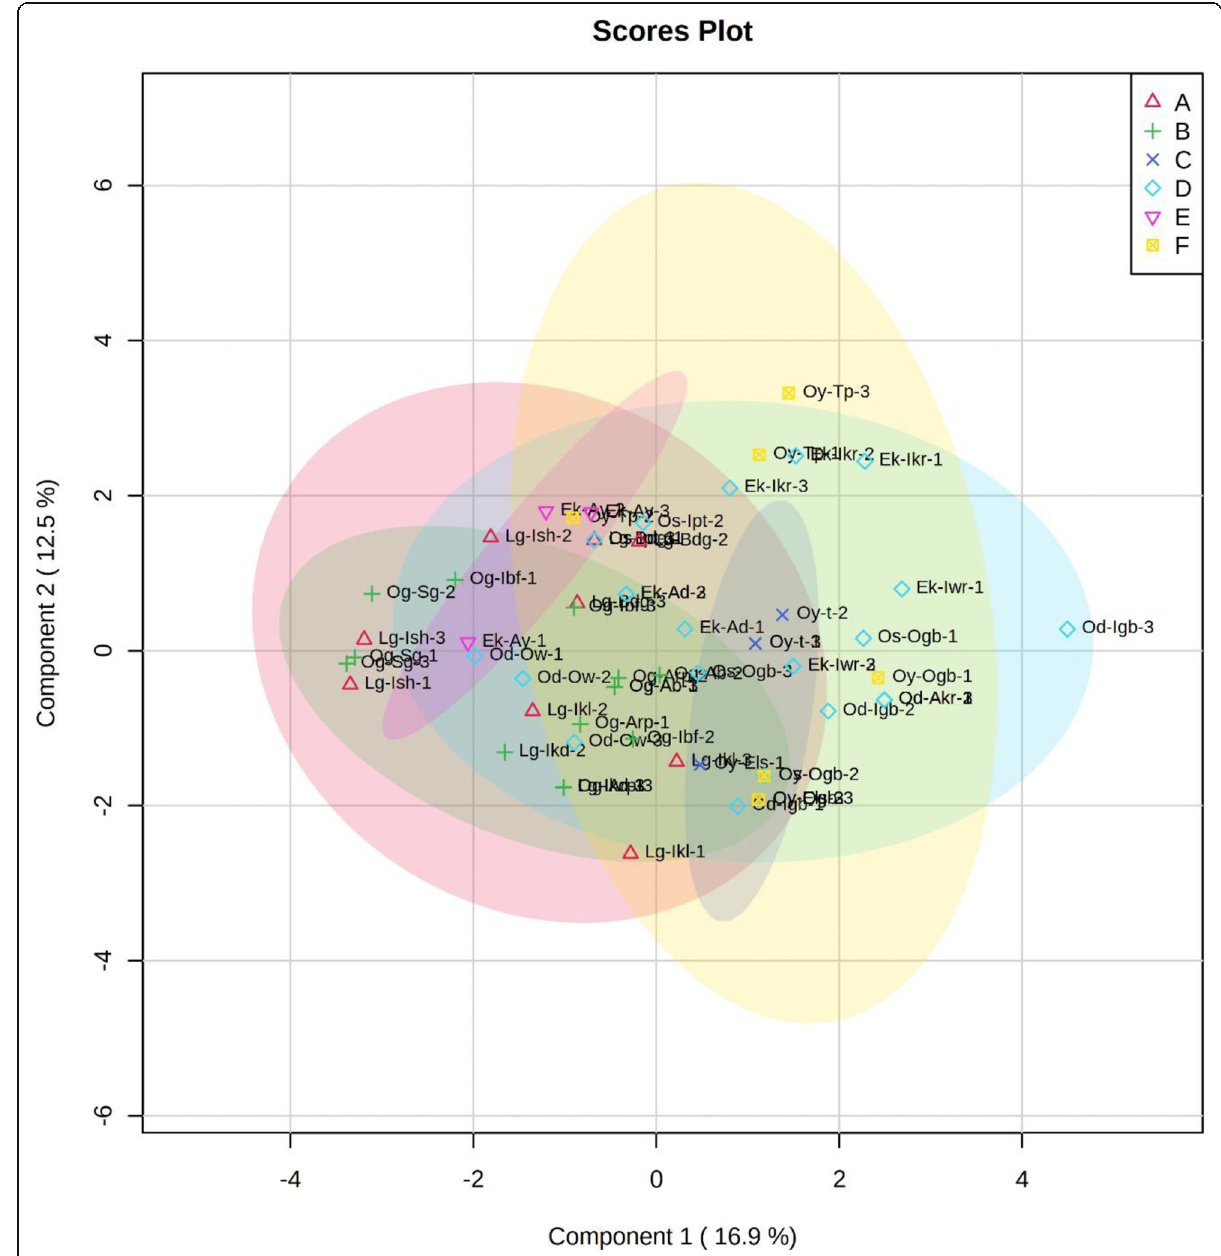
Fig. 13 PLS-DA plot from groups according to the type of soil as indicated by the Global Mapping Unit. A = 1656, B = 1550-1554, C = 1475, D = 1484-1487, E = 1588, F =